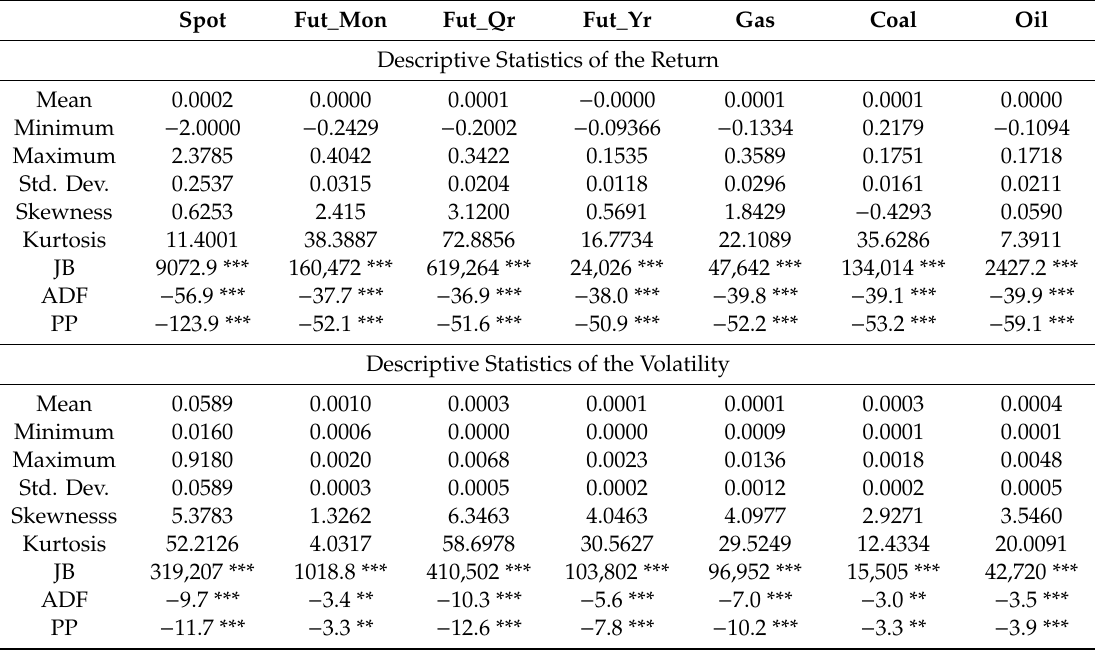
Table 4. Descriptive statistics of the return and volatility